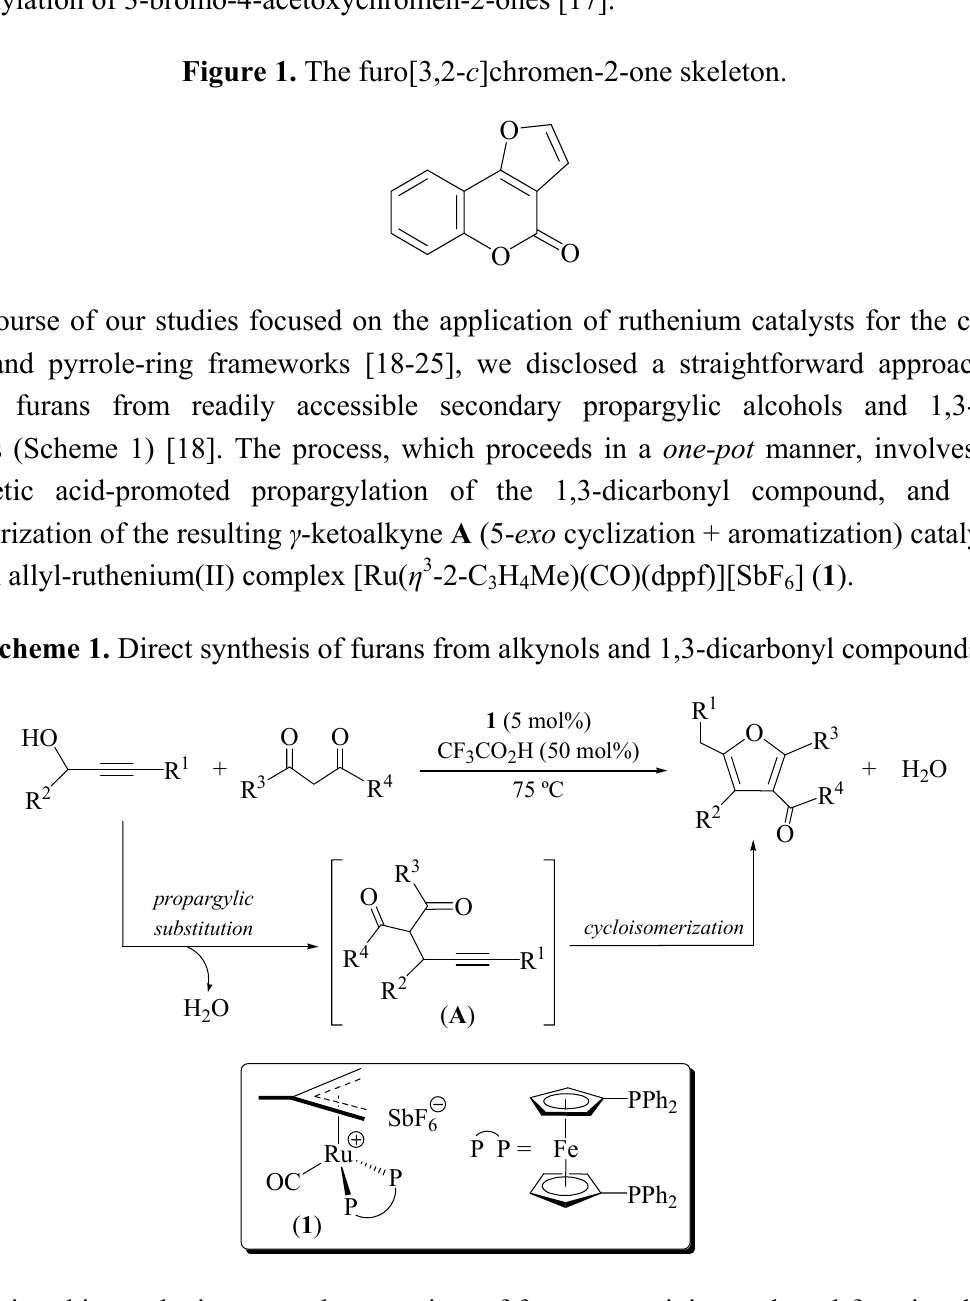
Figure 1. The furo[3,2- c ]chromen-2-one